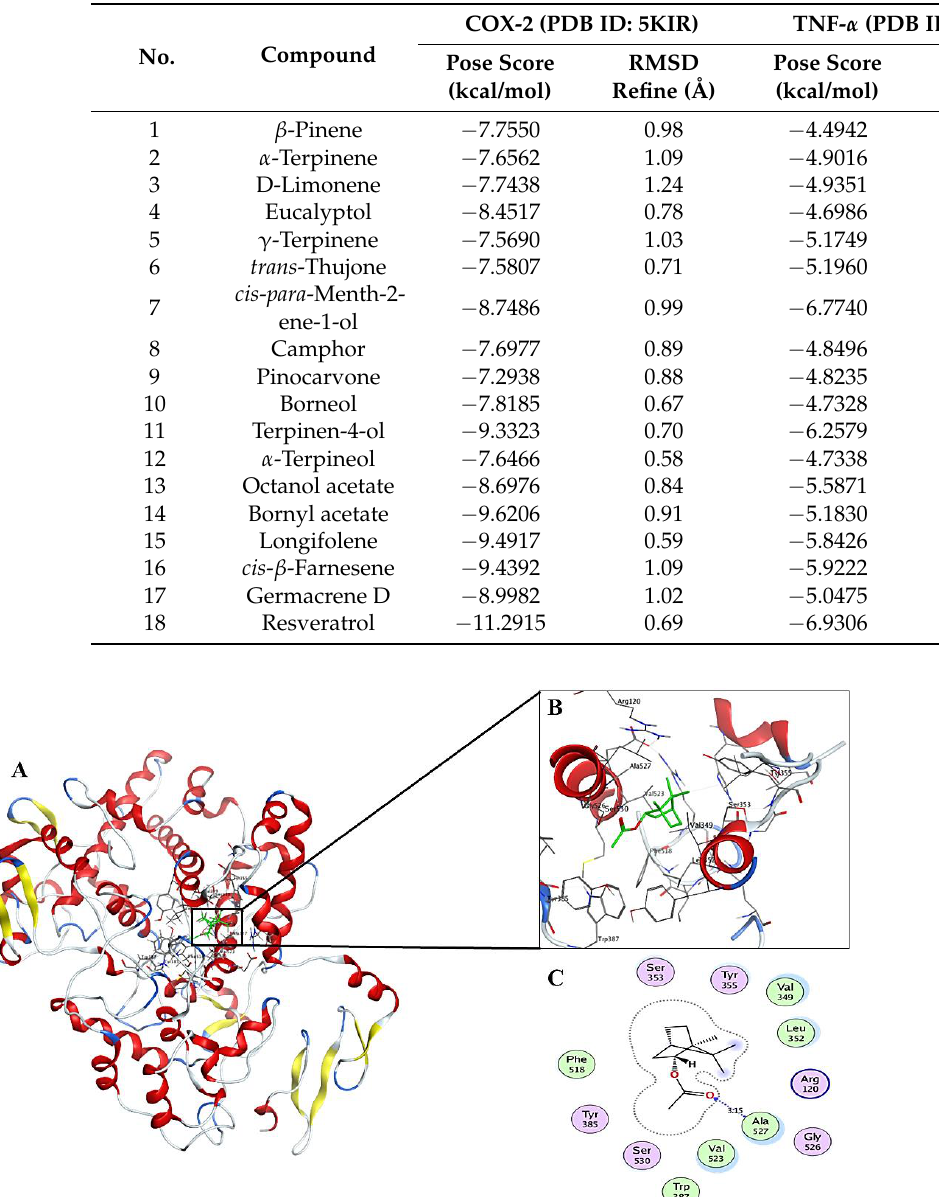
Table 2. Docking scores of identified compounds from the essential oil of C . anthemoides leaves, stems, and flowers against COX-2 (PDB ID: 5KIR) and TNF- α (PDB ID: 2AZ5) receptors.